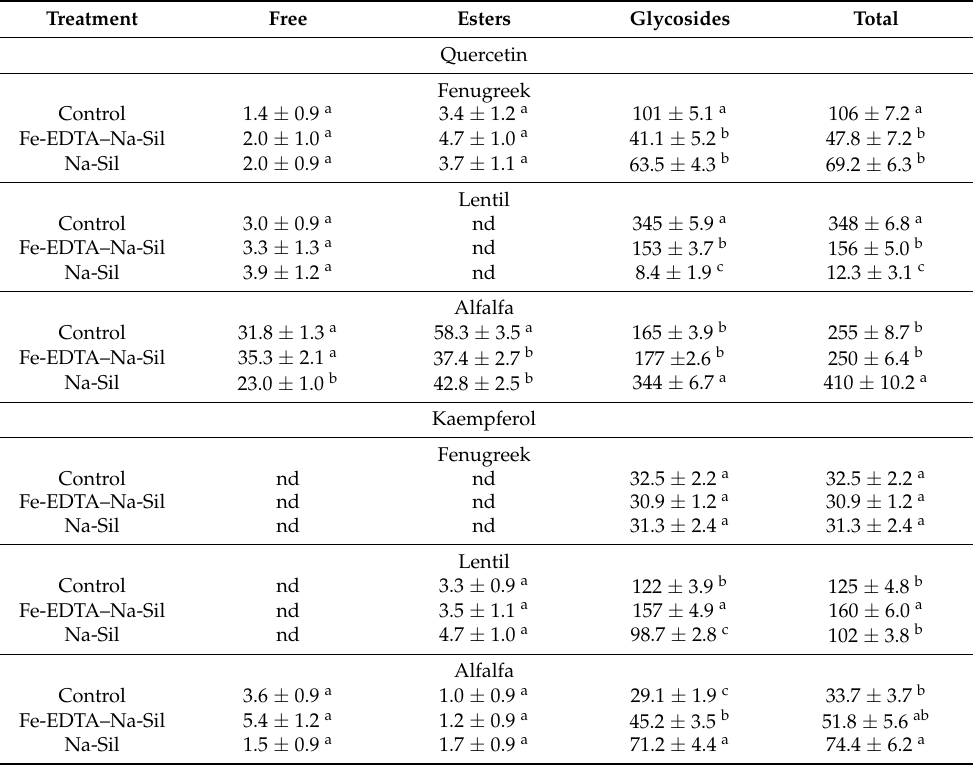
Table 2. The contents of quercetin and kaempferol (free and released from ester and O -glycoside forms) in legume sprouts ( µ g/g DW) treated with elicitors during